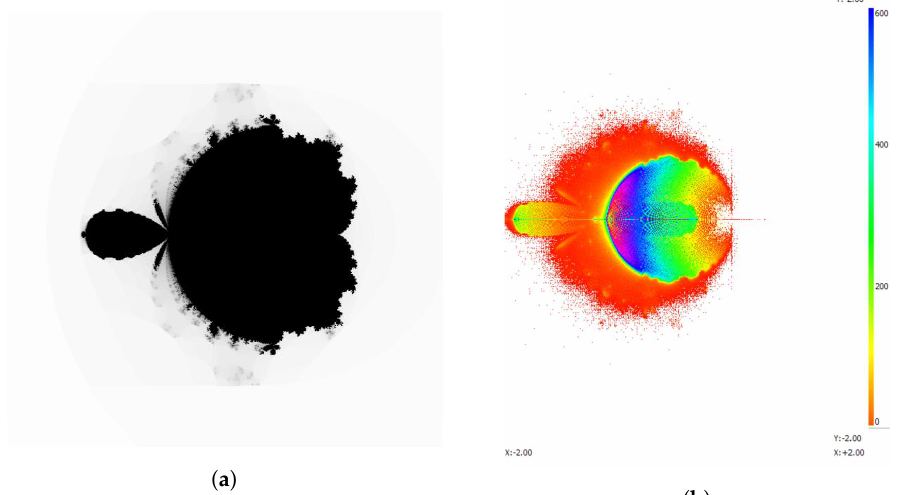
Figure 5. The Madelbrot set and accumulated map of S S 3,0.8,0.9 ( x ,1 ) iterating 128-times. ( a ) Mandel- brot set of S S 3,0.8,0.9 ( x ,1 ) ; ( b ) accumulated map of S S 3,0.8,0.9 ( x ,1 ) .